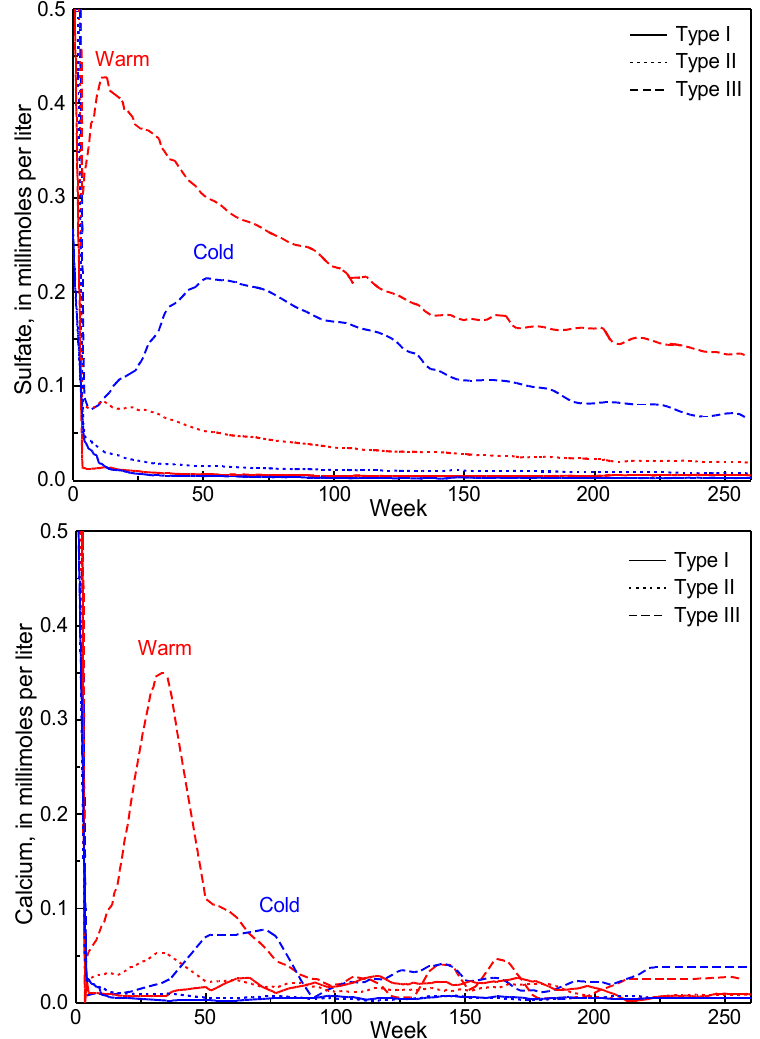
Figure 4. Temporal variation (moving average trendline of a 7-data point window) of SO and Ca in leachate from warm and cold humidity